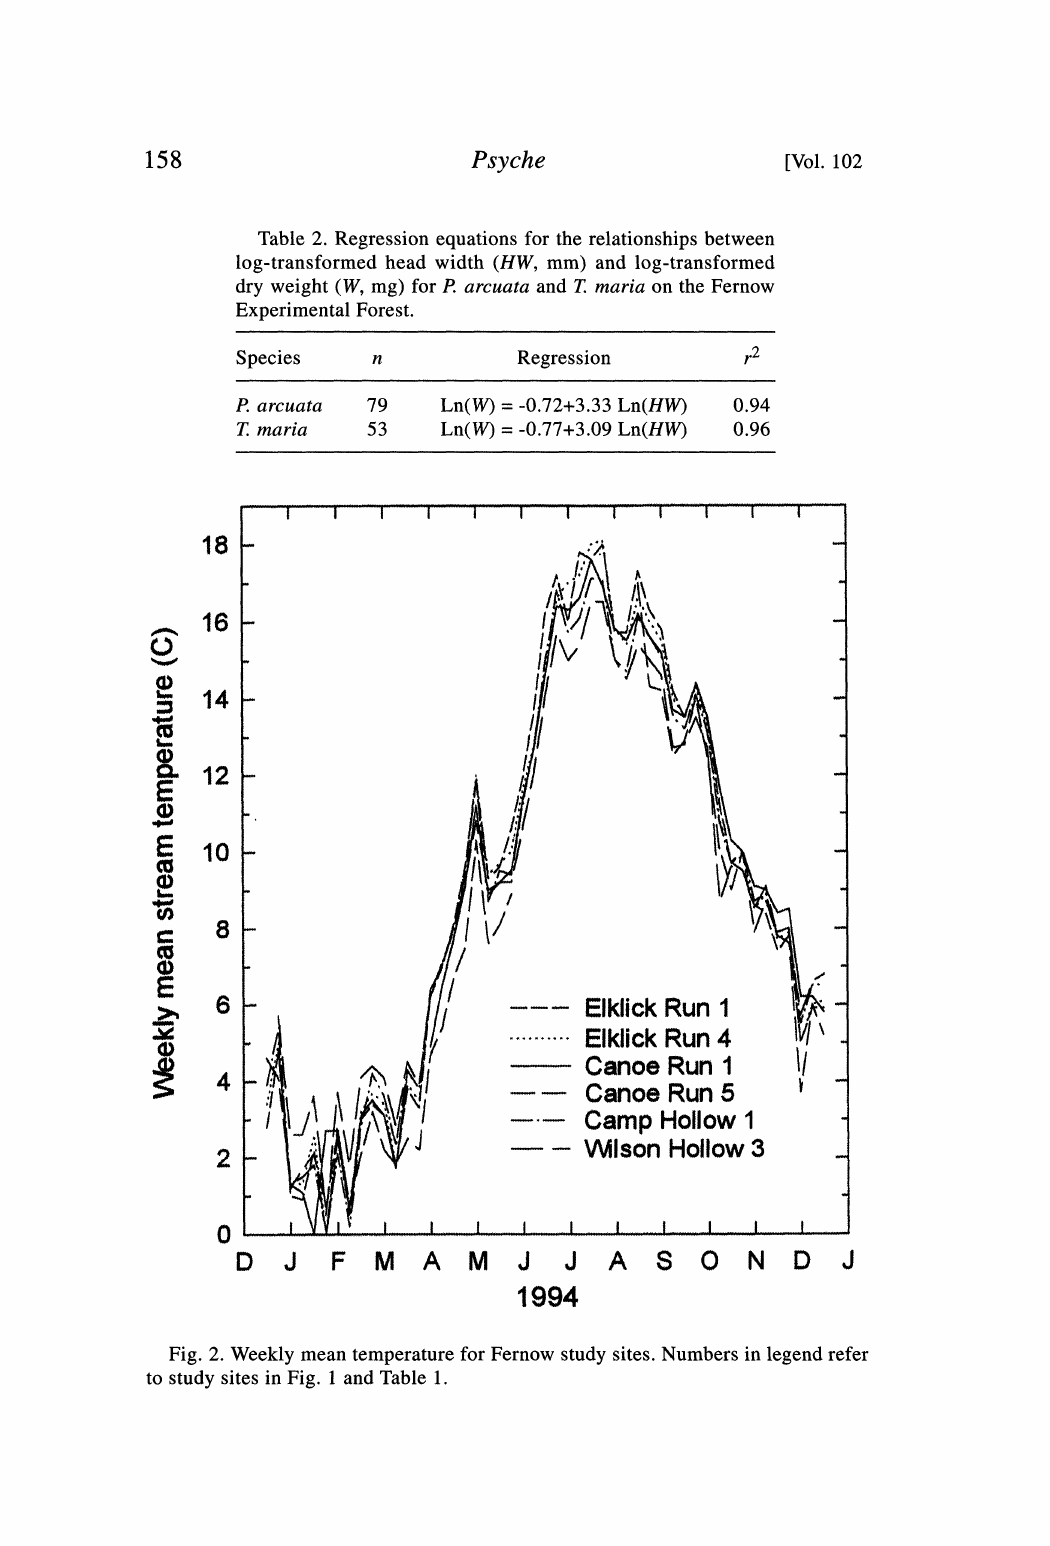
Fig. 2. Weekly mean temperature for Fernow study sites. Numbers in legend refer to study sites in Fig. and Table